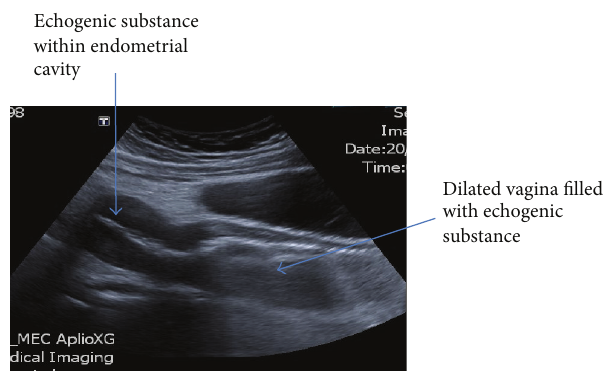
Figure 3: Sagittal view T1 weighted MRI abdomen/pelvis.